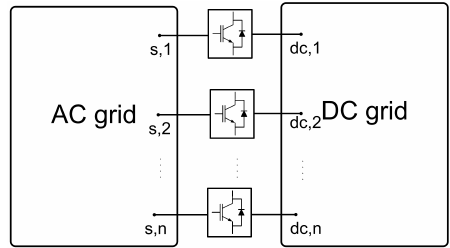
Figure 1. Hybrid voltage source converters (VSC)-based AC/DC